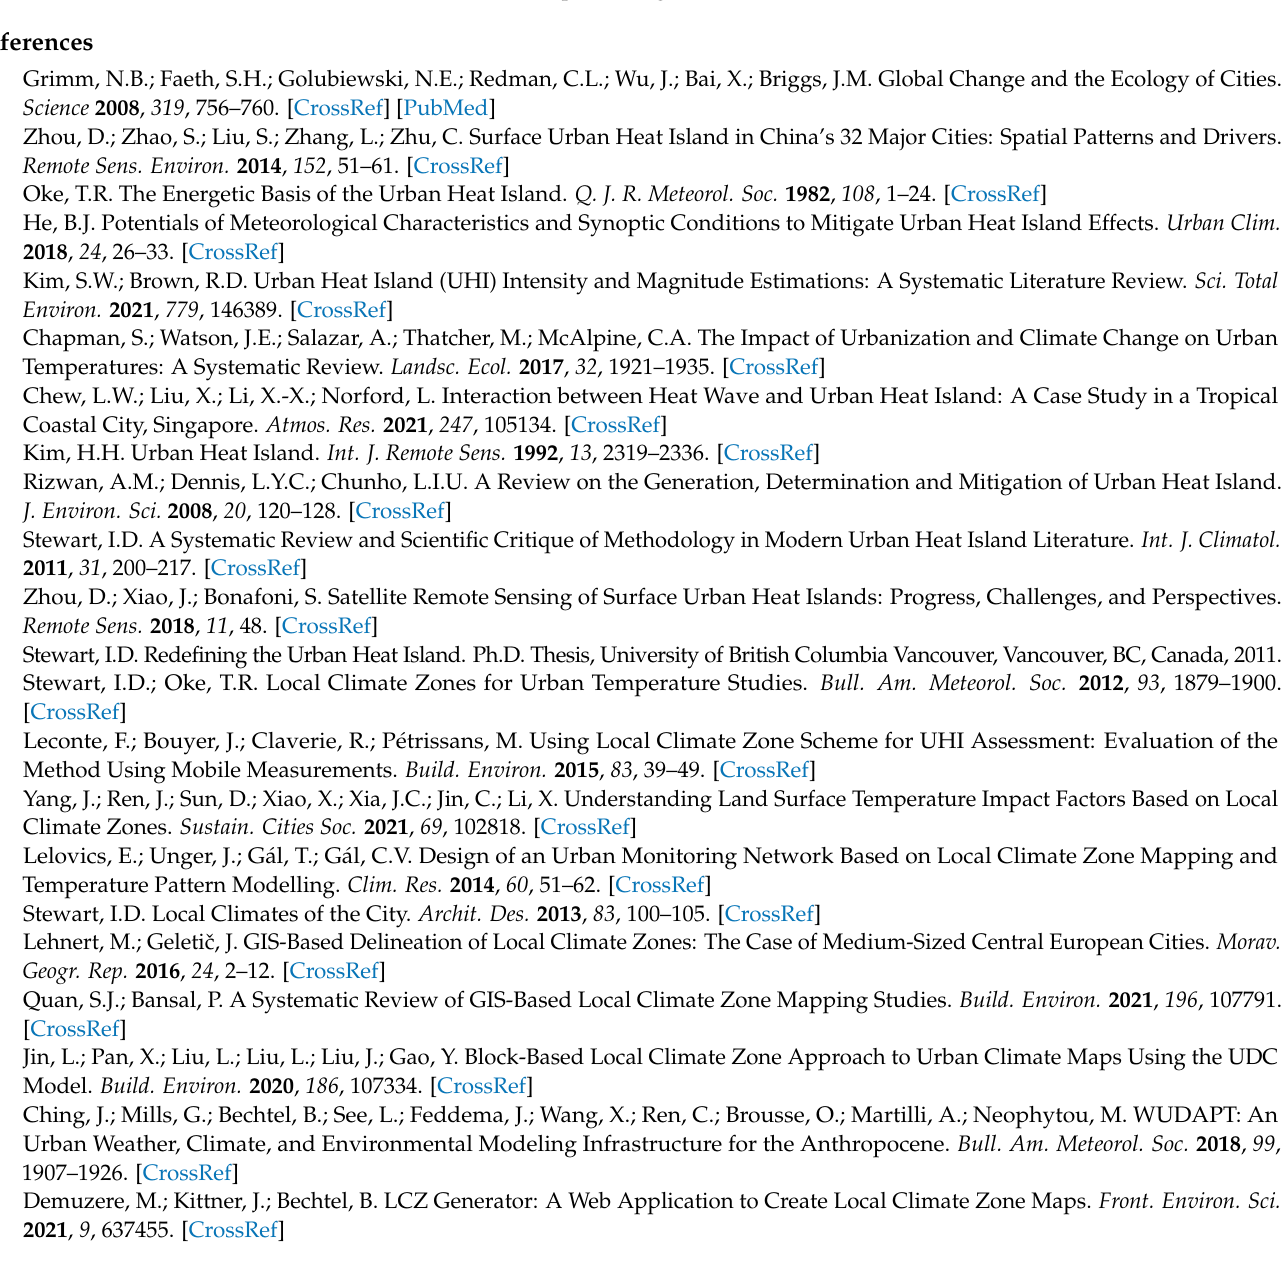
Figure A1. Sentinel-1 data processing flow.